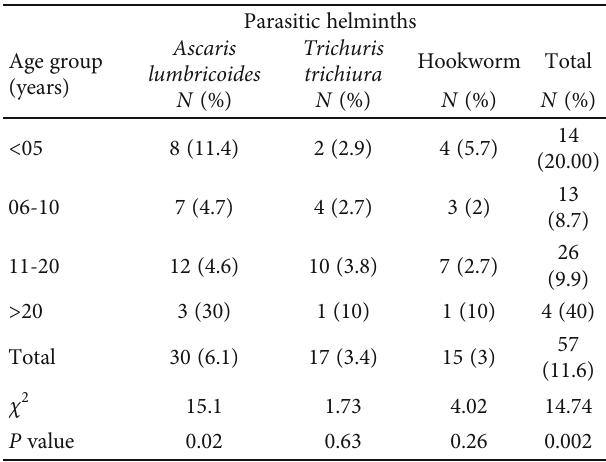
Table 4: The prevalence of helminth infection according to age